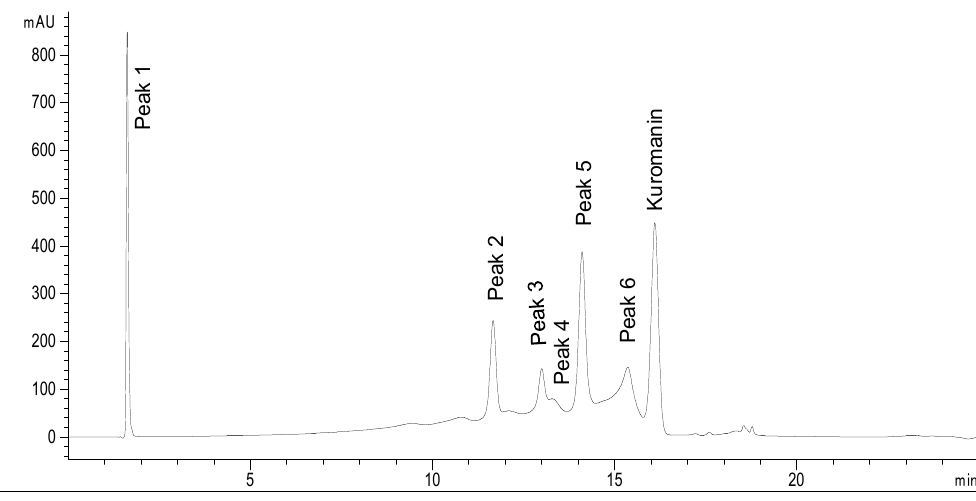
Figure 3. HPLC chromatogram of freeze-dried chokecherry. Anthocyanins are identified as Peak 1 to 6 and kuromanin according to the retention time of a standard.